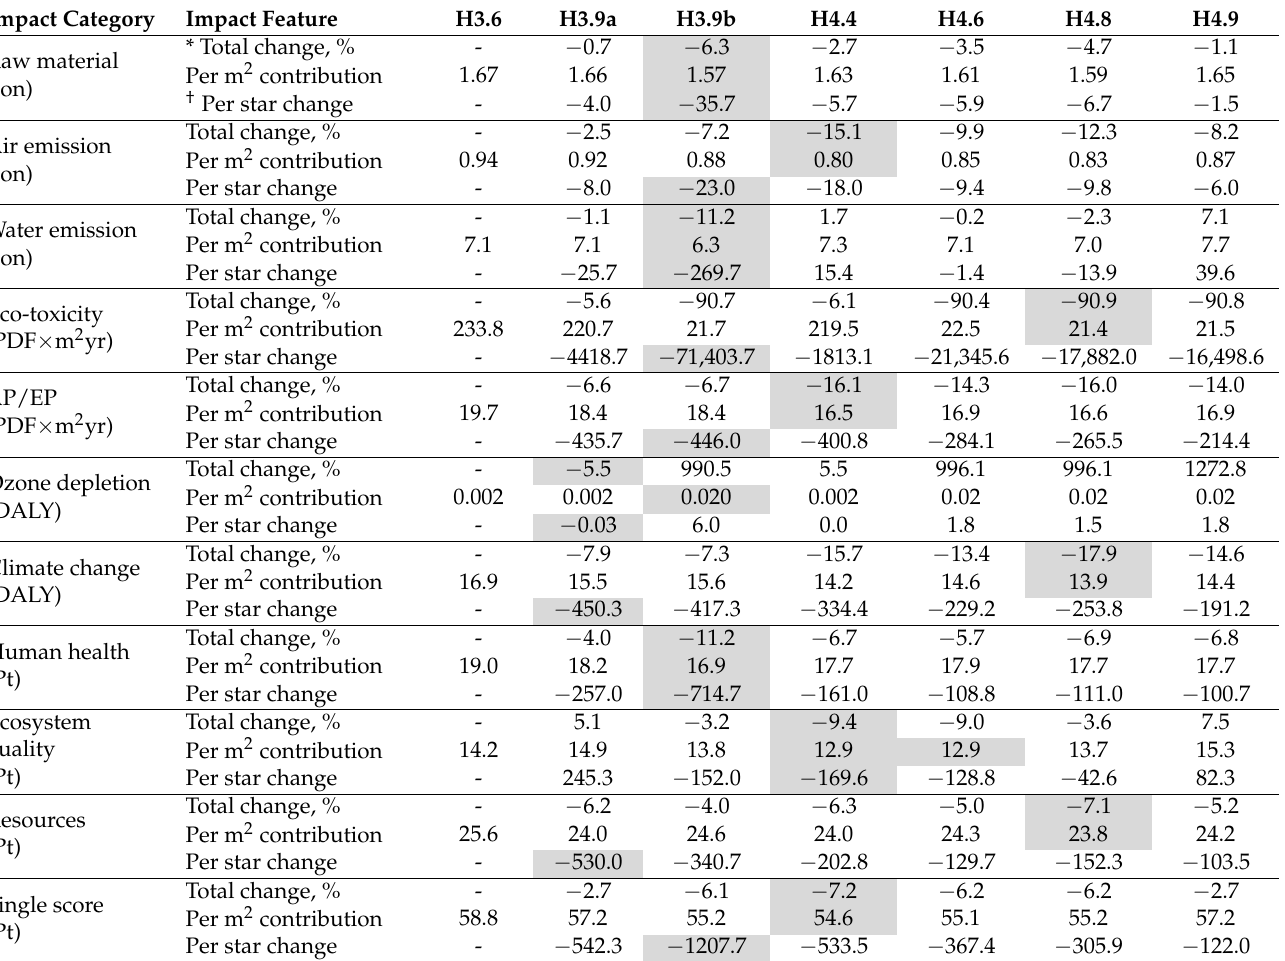
Table 10. Changes in different houses with respect to the Base House for different impact